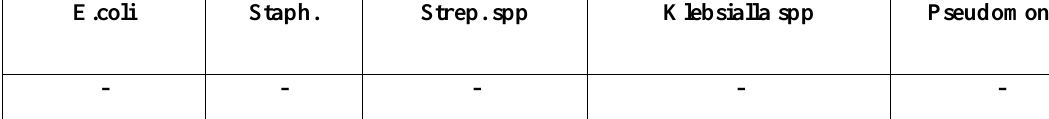
Table (3) PMF antimicrobial sensitivity test